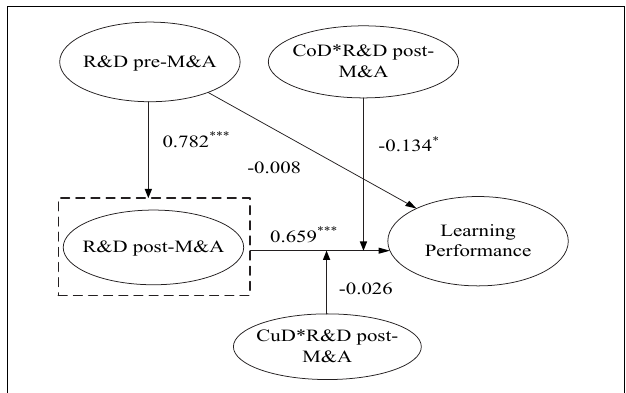
FIGURE 3 | Path analysis results of learning mechanism 2. * p < 0.05 (two-tailed); *** p < 0.01 (two-tailed).